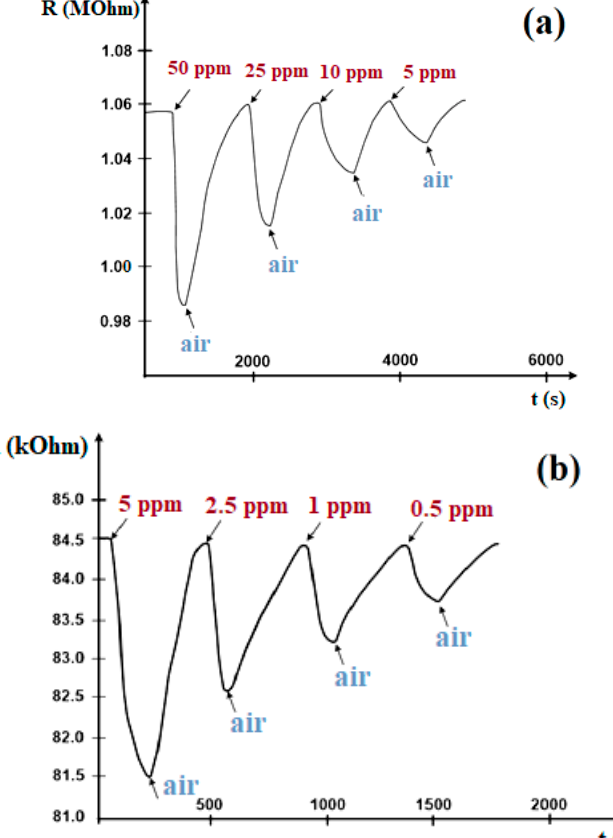
Figure 3. The real-time sensor response to various NO 2 concentrations: ( a ) Type 1 sensor (working temperature is 80 ◦ C); ( b ) Type 2 sensor (working temperature is 22 ◦